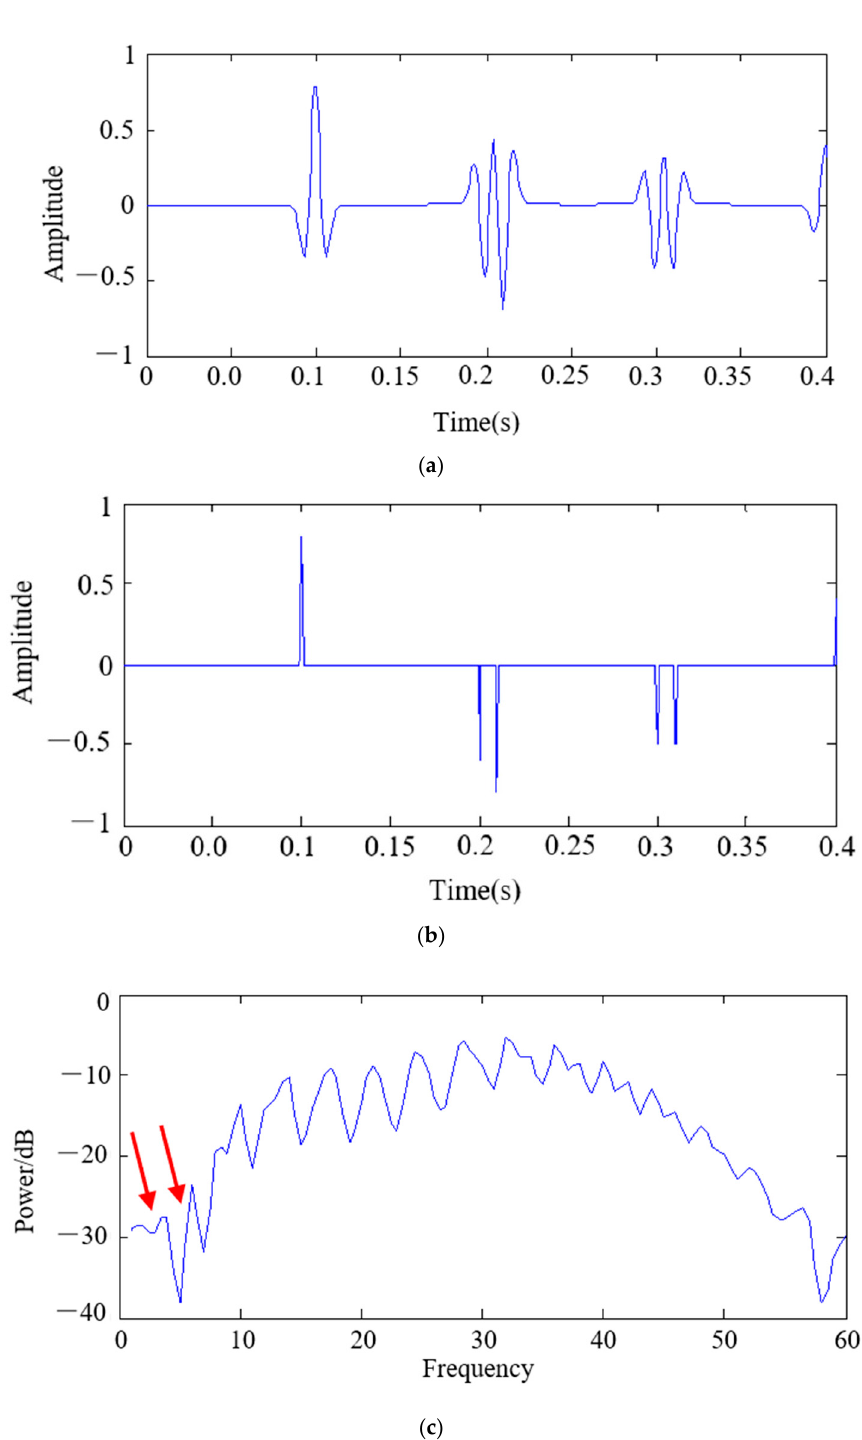
Figure 4. Simulated seismic data. ( a ) Model data, ( b ) reflection coefficient model, ( c ) frequency spectrum of ( a ).